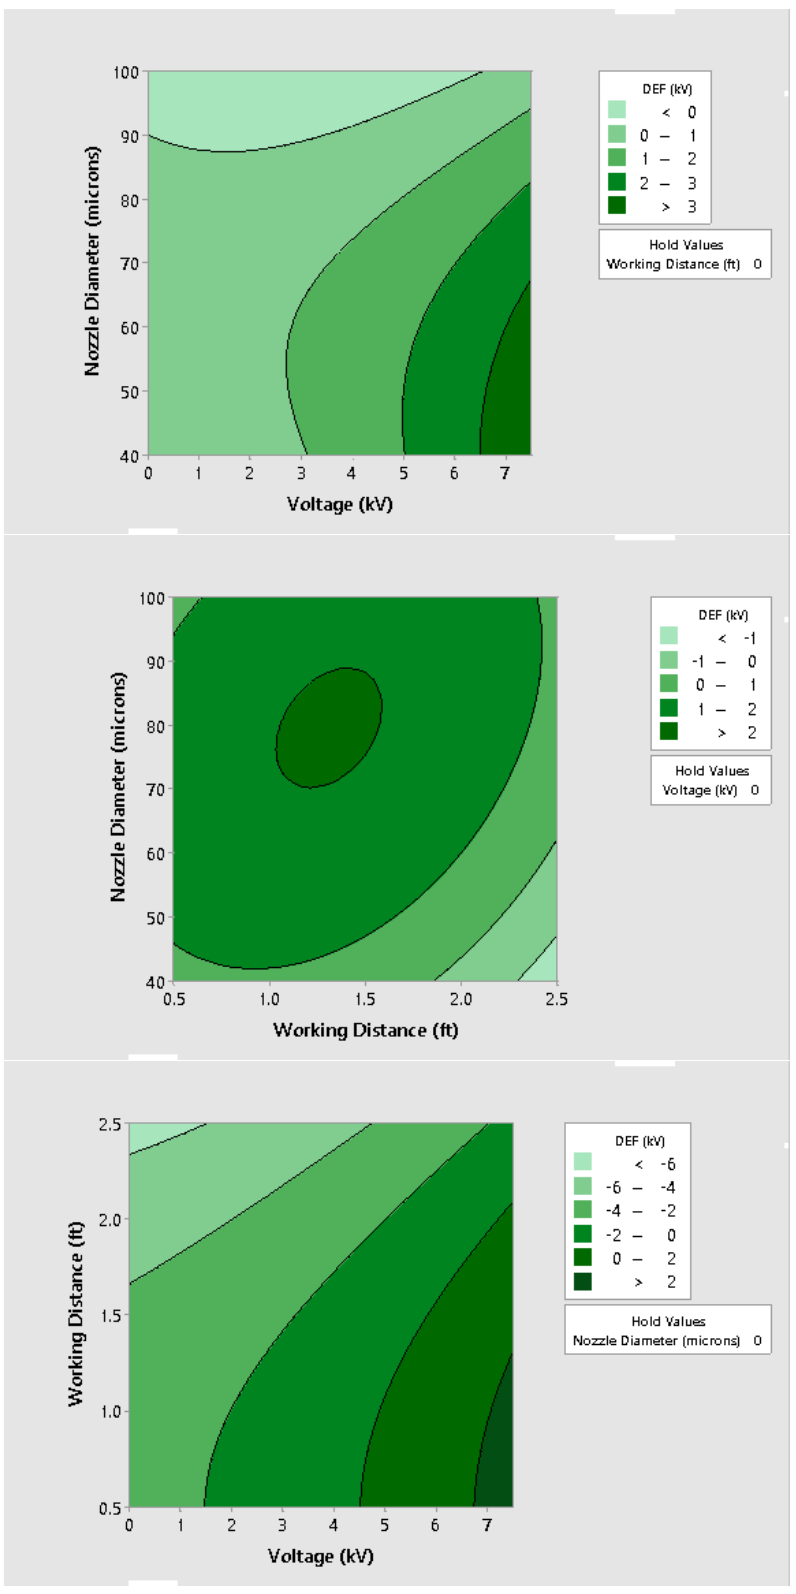
Figure A20. POLYETHYLENE PLASTIC: Quantitative representation of average differential electric field vs. working distance (feet), nozzle sprayer size ( µ m), and charge voltage